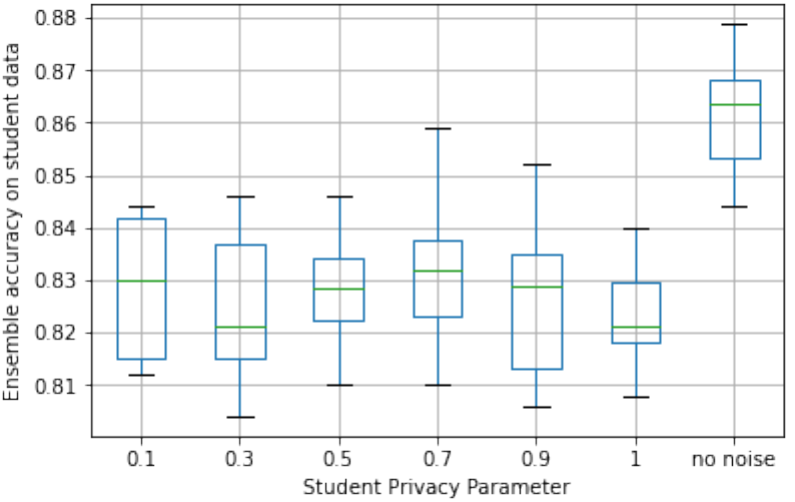
Figure 8. Ensemble accuracy evaluated on student data by privacy parameter ρ in ECG